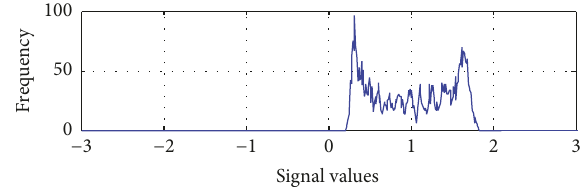
Figure 9: Received signal distribution after FFT window adjust- ment.